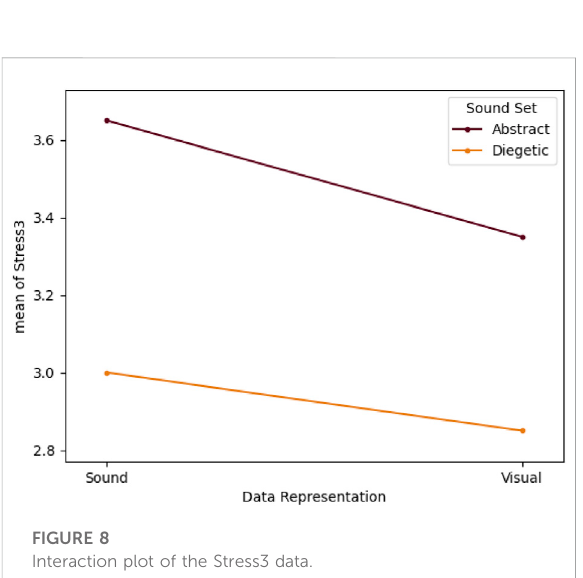
FIGURE 8 Interaction plot of the Stress3